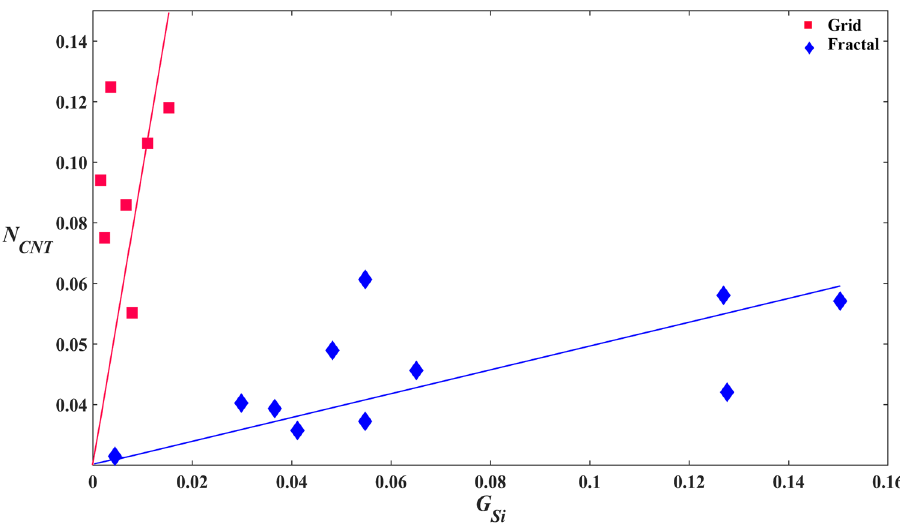
Figure 7. Study of the relationship of N CNT with G Si for the grid and fractal electrodes. Scatterplot of N CNT versus G Si for the grids (red) and fractals (blue). The solid red and blue lines are fits through zero for the grids and fractals,